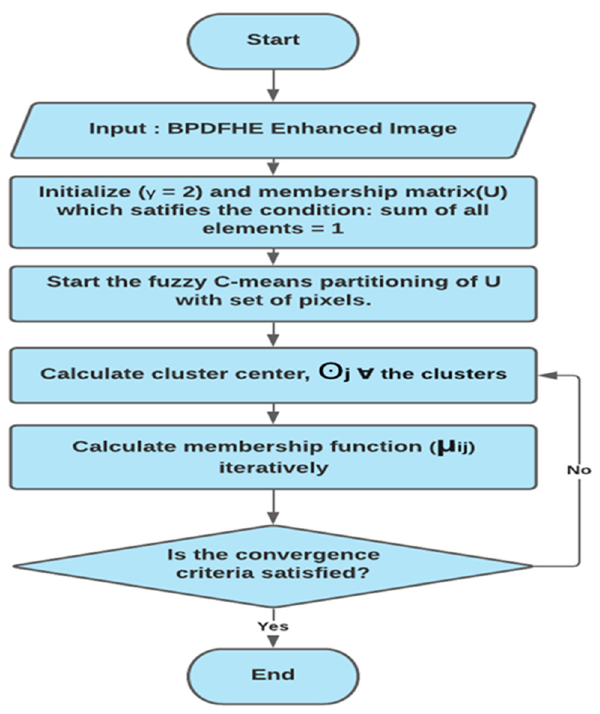
Figure 2. Flowchart for FCM algorithm.